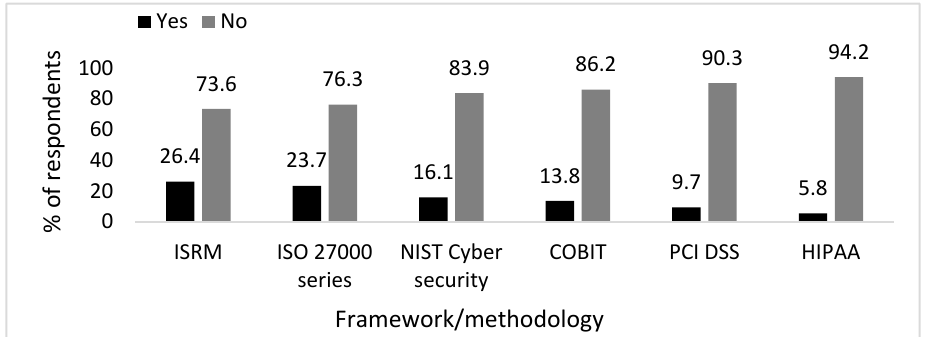
Figure 5. Frameworks and standards referenced in tools for Cloud BI evaluation.